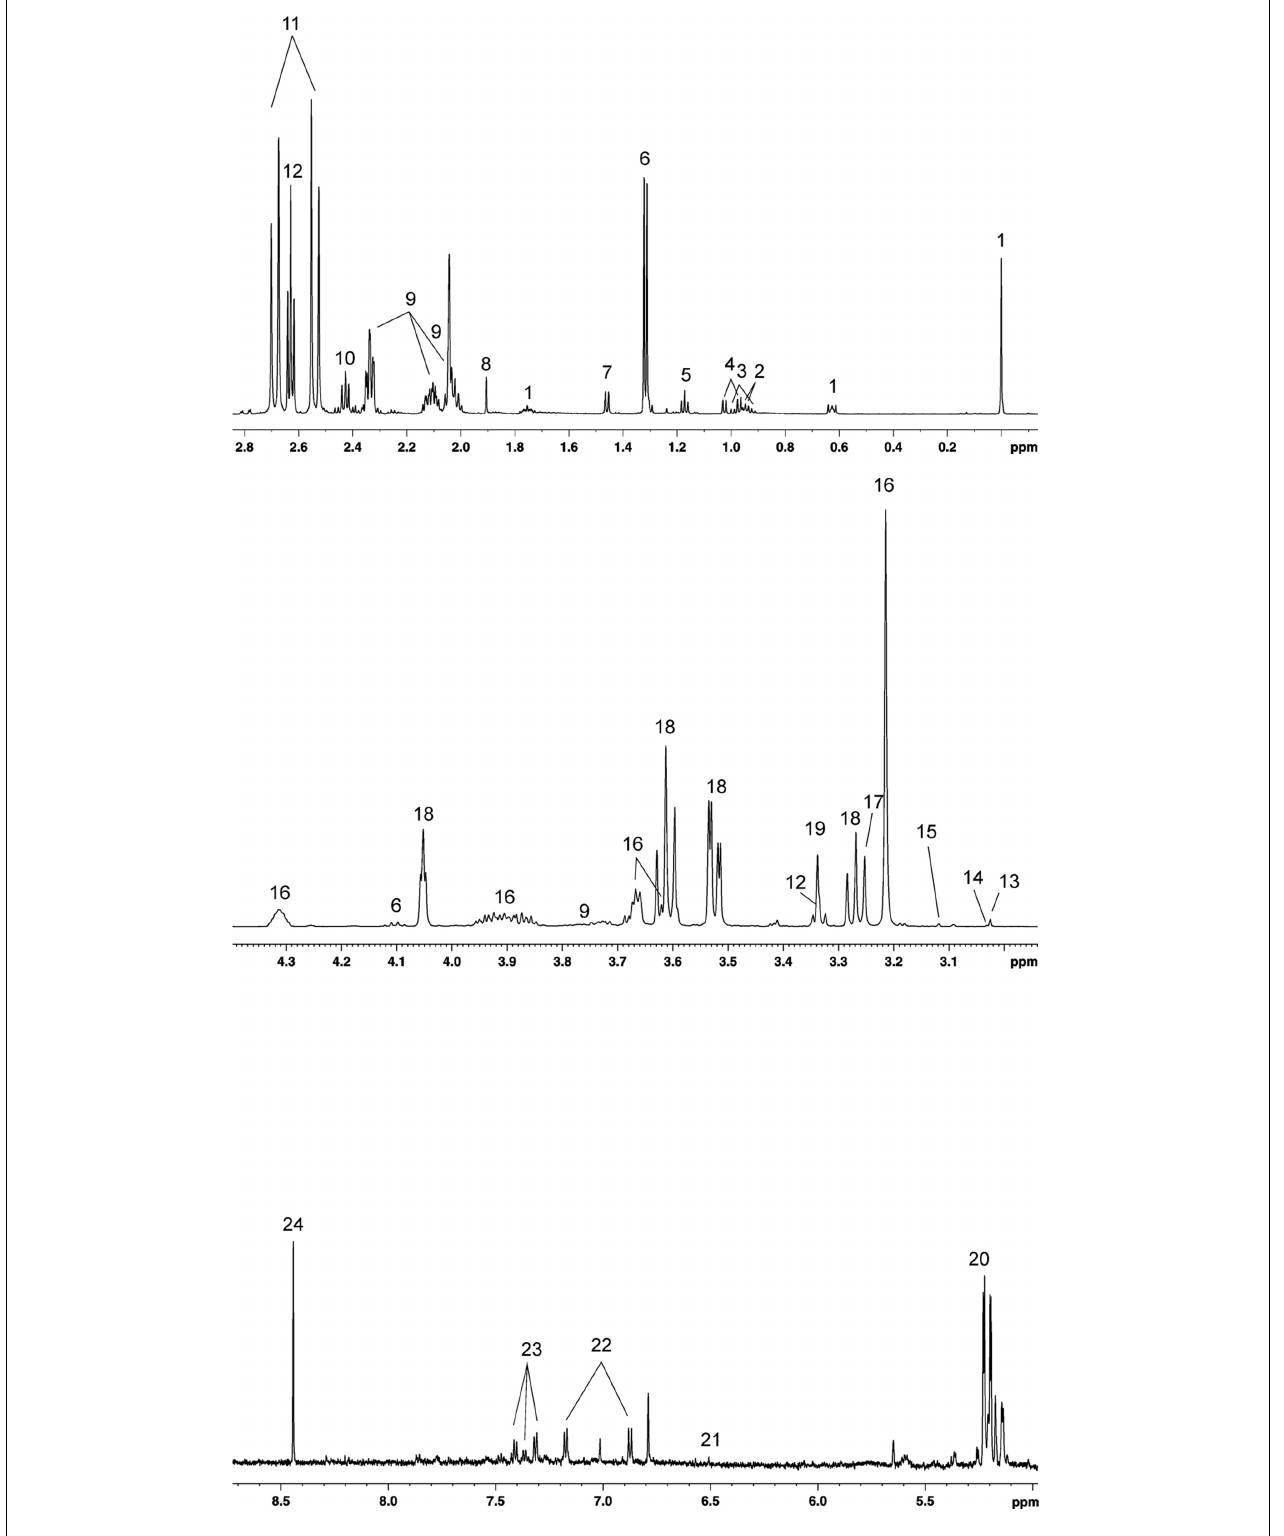
FIGURE 1 | 1H-NMR (noesygppr1d) profile (600MHz) from 0 to 8 ppm of pig seminal plasma. (1) DSS, (2) leucine, (3) isoleucine, (4) valine, (5) ethanol, (6) lactate, (7) alanine, (8) acetate, (9) glutamate, (10) carnitine, (11) citrate, (12) hypotaurine, (13) creatine, (14) creatine phosphate, (15) malonate, (16) sn-glycero-3-phosphocholine, (17) TMAO, (18) myo-inositol, (19) methanol, (20) glucose, (21) fumarate, (22) tyrosine, (23) phenylalanine, and (24) formate.